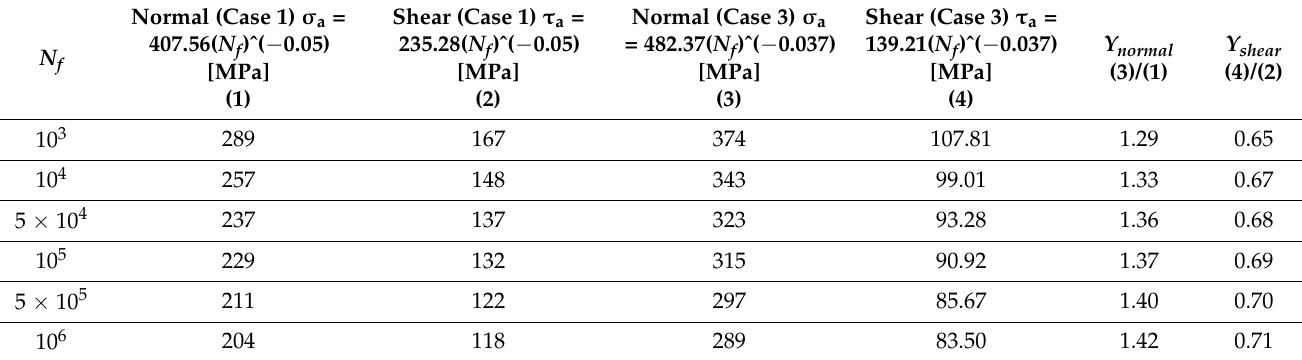
Table 6. Y results for case 1 vs. case